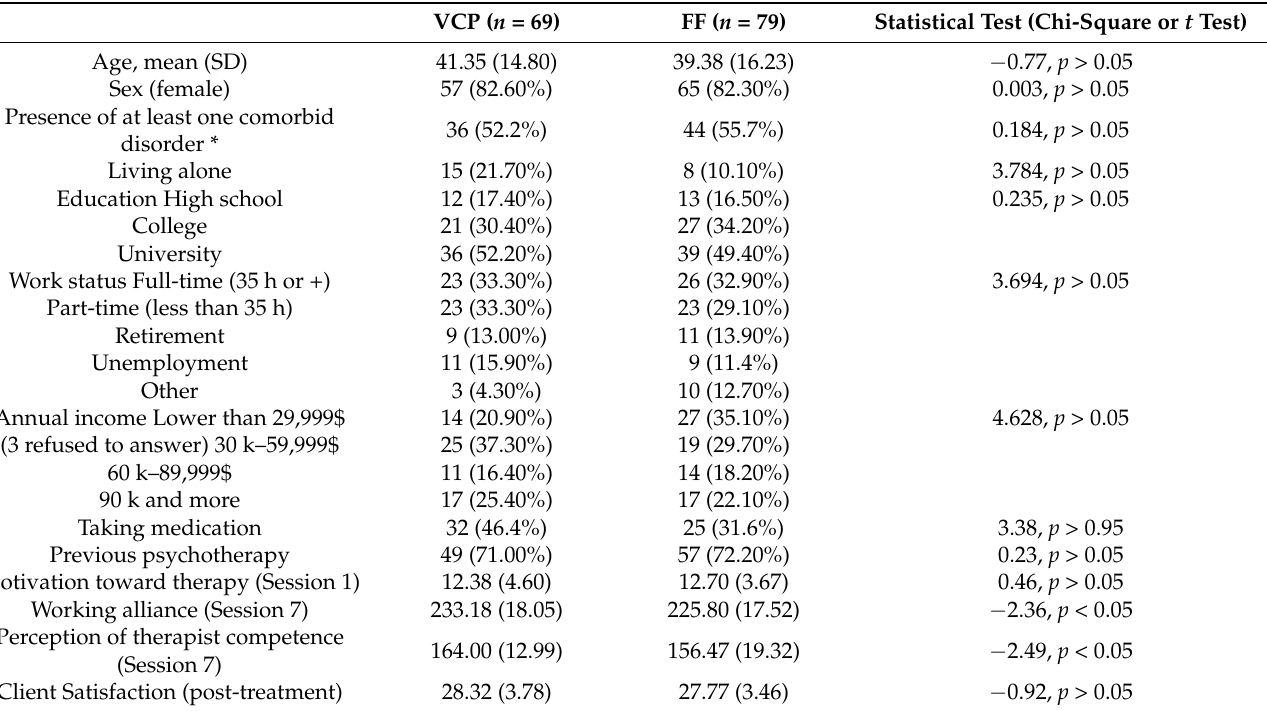
Table 1. Descriptive statistics of the intent-to-treat sample of participants diagnosed with generalized anxiety disorder who received cognitive-behavior therapy either by videoconference (VCP) or face- to-face